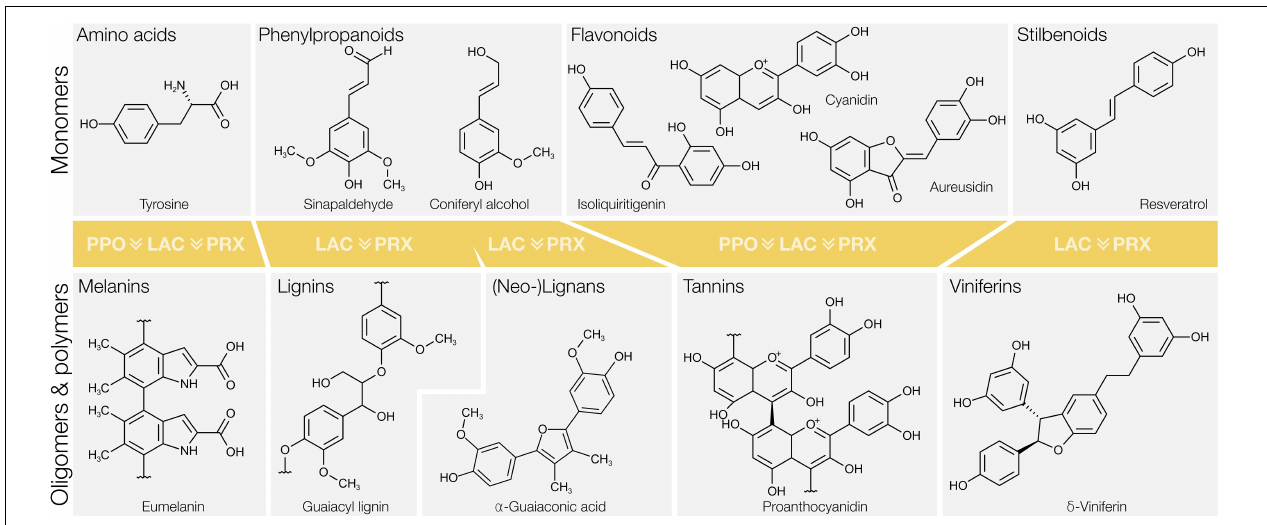
FIGURE 1 | Main groups of phenolic compounds in monomeric state and after oxidative coupling catalysed by phenoloxidases. Note that peroxidases (PRX) and laccases (LAC) can oxidise most types of phenolics in contrast to polyphenol oxidases (PPO). Note also the historical substrate ( α -guaiaconic acid) used for the discovery of phenoloxidases, which turns blue after enzymatic oxidation by forming